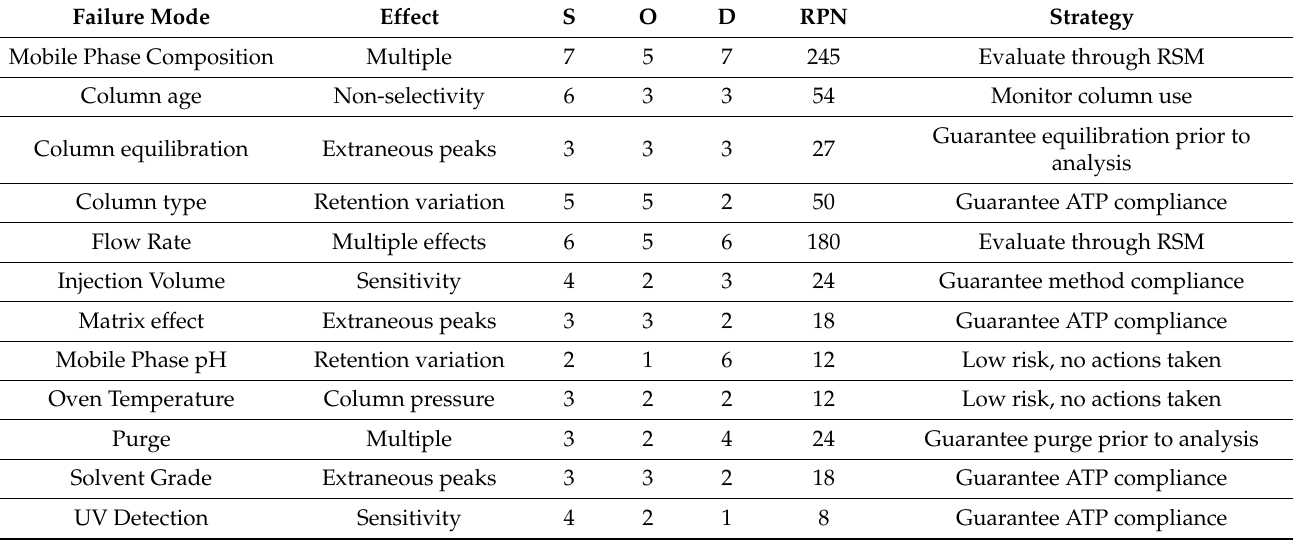
Table 3. Failure mode and effect analysis (FMEA) for establishing critical method parameters (CMPs).